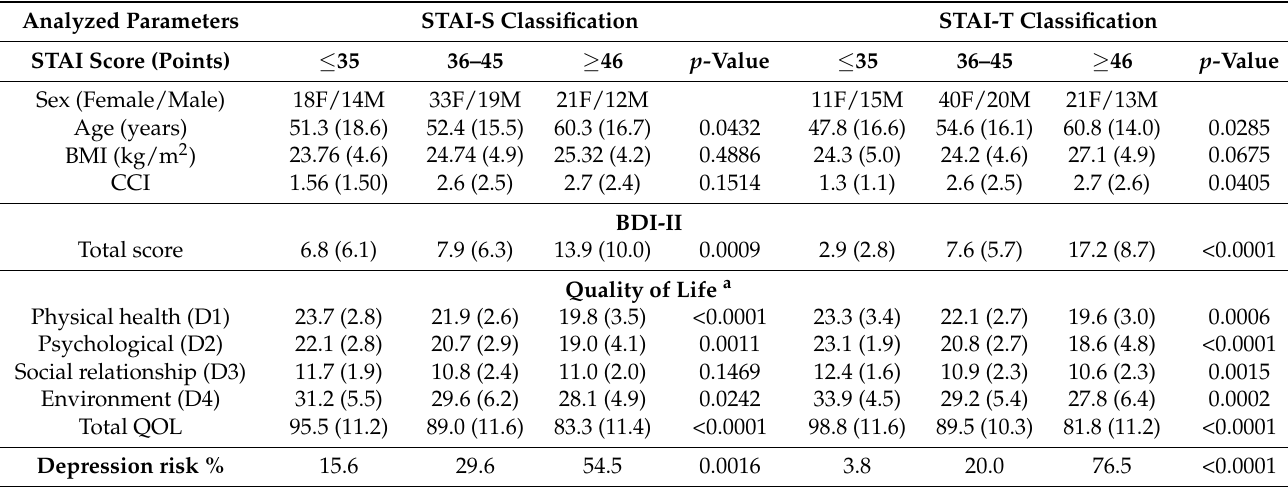
Table 4. The STAI-score classification, depression, and quality of life in patients undergoing diagnostic FVB. Analyzed